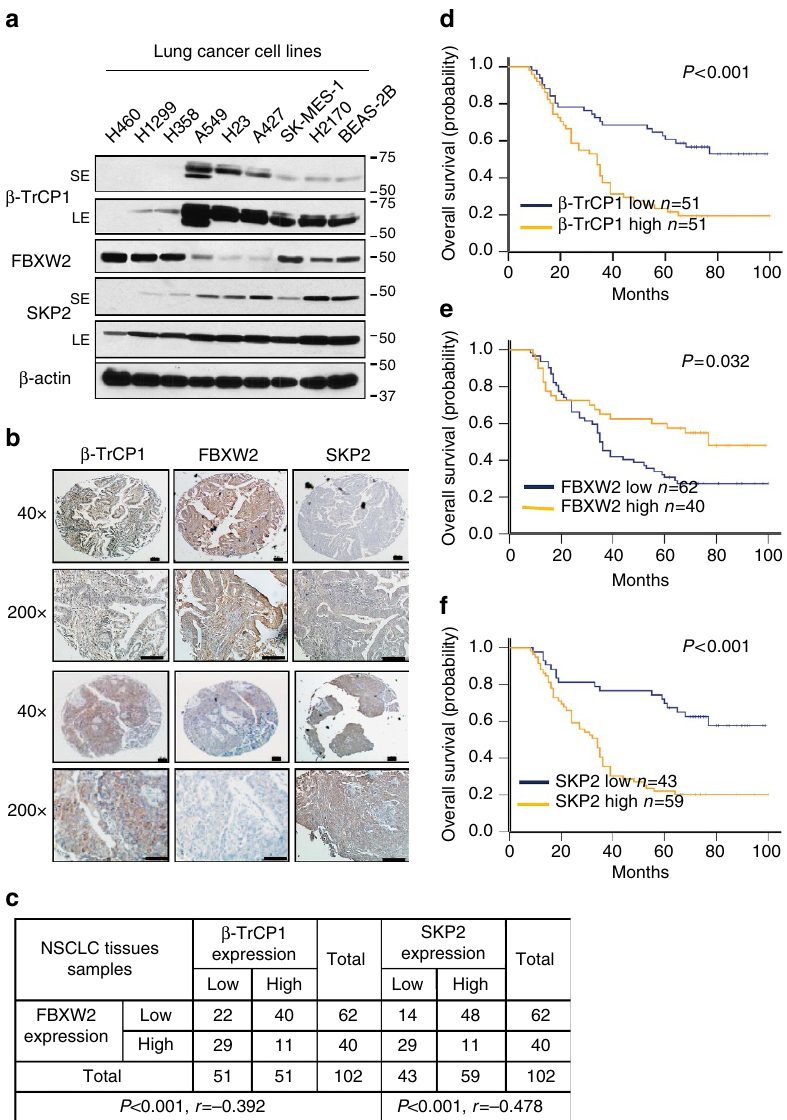
Figure 6 | Expression of b -TrCP1/FBXW2/SKP2 in lung cancer cell lines and cancer tissues and their association with patient survival. ( a – c ) Expression levels among three F-box proteins in lung cancer cell lines and tissues: Cell lysates from eight lung cancer cell lines and one immortalized line (BEAS-2B) were subjected to IB ( a ); SE: Short exposure; LE: Long exposure. Lung cancer tissue microarrays were stained with indicated Abs and photographed ( b , Scale bars, 100 m m), and data were then analysed using SPSS software to obtain coefficient ( c ; P o 0.001, Pearson’s test). ( d – f ) Protein expression of three F-box proteins in lung cancer and their relationship with patient survival: Continuous protein expression values were classified into the low and high groups with equal number of patients, and 5-year survival time was used for Kaplan-Meier survival analysis ( d – f ). Kaplan-Meier survival analysis indicated that patient with higher expression of FBXW2 was related to a better overall survival (log-rank test, P ¼ 0.032) ( e ); Higher expression of b -TrCP1 and SKP2 were related to a worse overall patient survival (log-rank test, P o 0.001 and 0.001, respectively) ( d , f